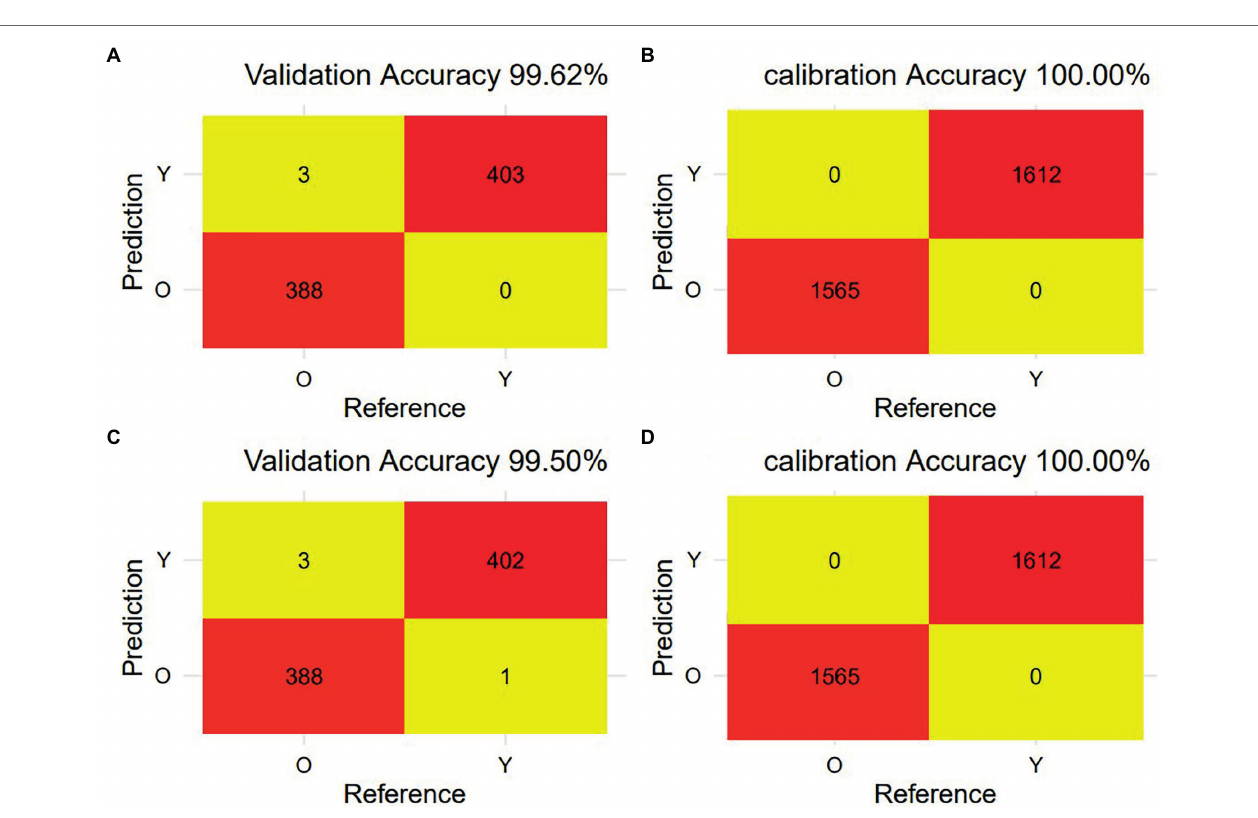
FIGURE 5 | The misclassification of young and old leaves of Toona sinensis from calibration and validation the SVM model using raw VIS–NIR spectra and feature variable VIS spectrum. (A) The confusion matrix of misclassification for validation data of raw VIS–NIR spectra predicted; (B) The confusion matrix of misclassification for calibration data of raw VIS–NIR spectra predicted; (C) The confusion matrix of misclassification for validation data of feature variable VIS spectrum predicted; (D) The confusion matrix of misclassification for calibration data of feature variable VIS spectrum